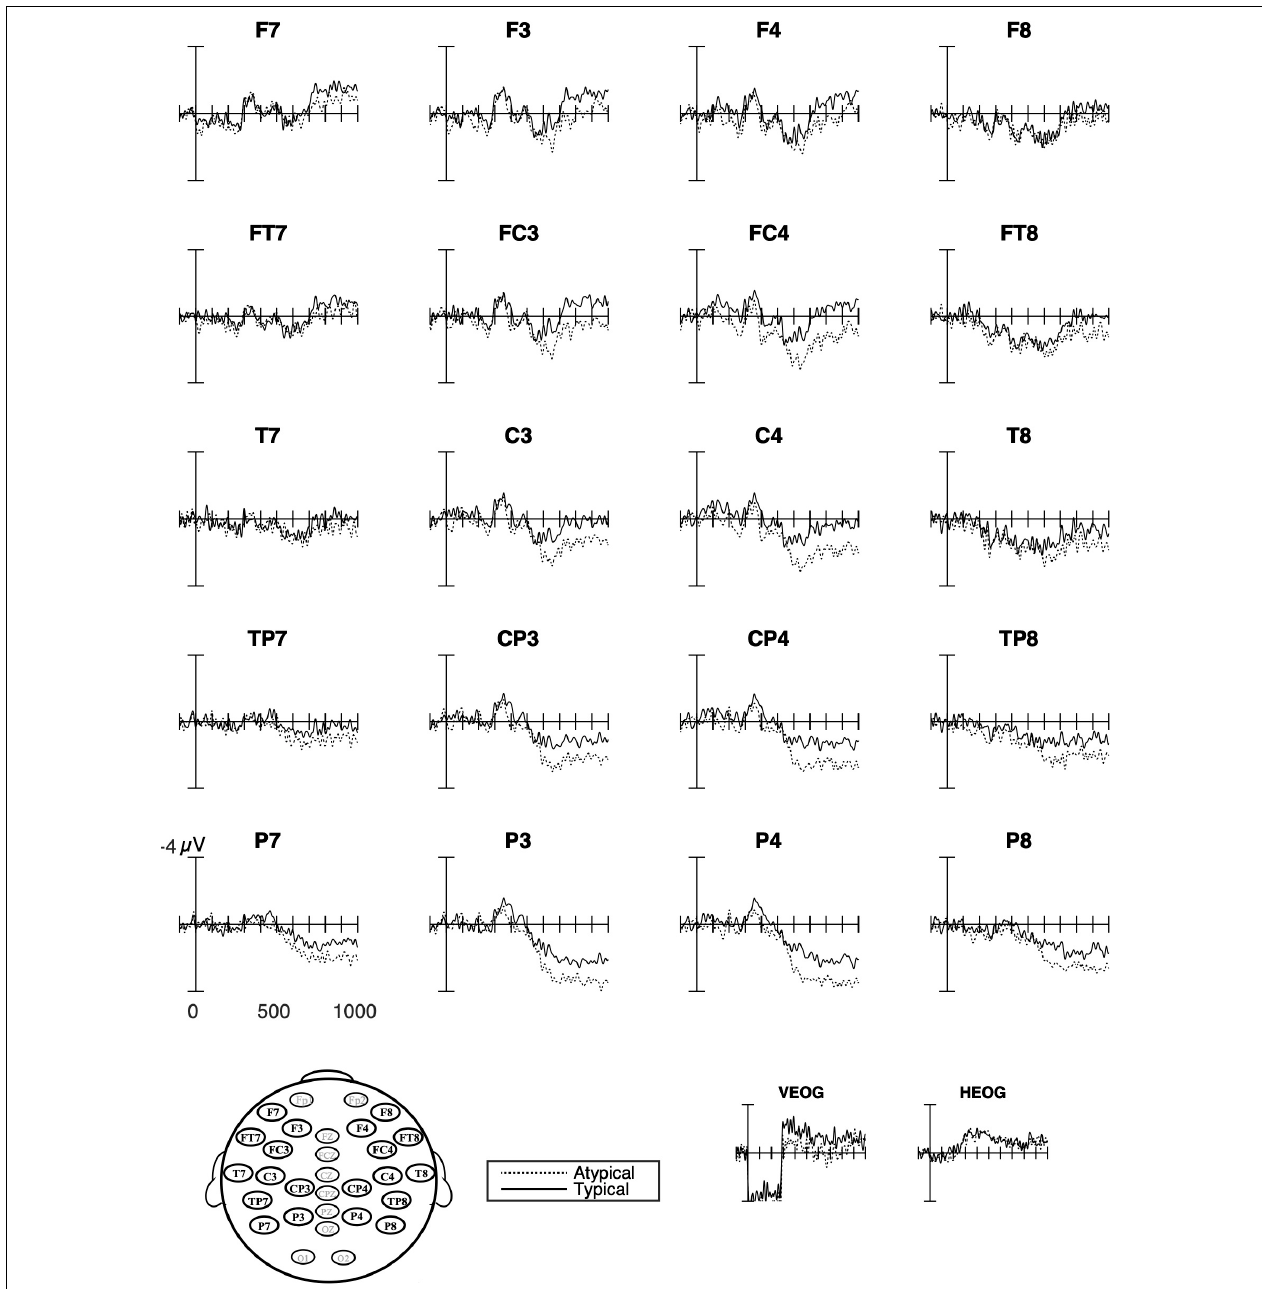
FIGURE 9 | Grand average ERPs for English learners. The response to typical verb use (number of trials in the bin, n = 529) as solid lines and to atypical verb use ( n = 525) as dashed lines. The waveforms suggest a broadly distributed medial positivity for the atypical use of placement verbs.